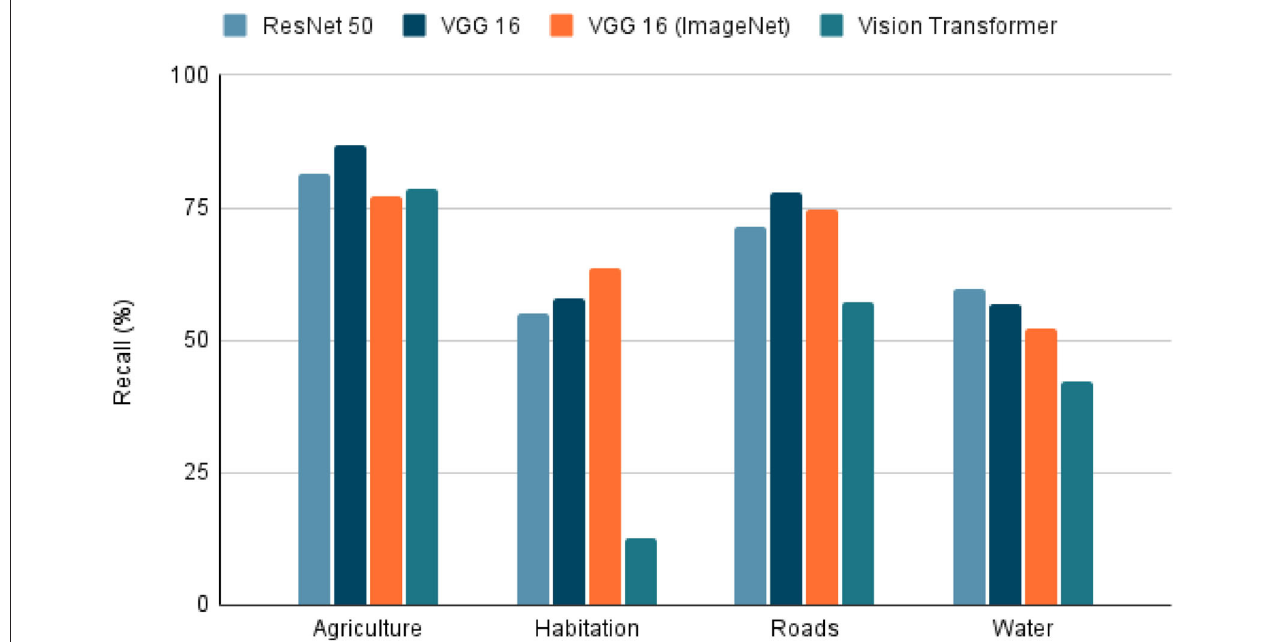
FIGURE 7 | Recall on tested models. Recall of the 4 models tested in the extraction of the 4 characteristics (agriculture, habitation, roads, whater). A highest value indicates a better performance in the classification task.